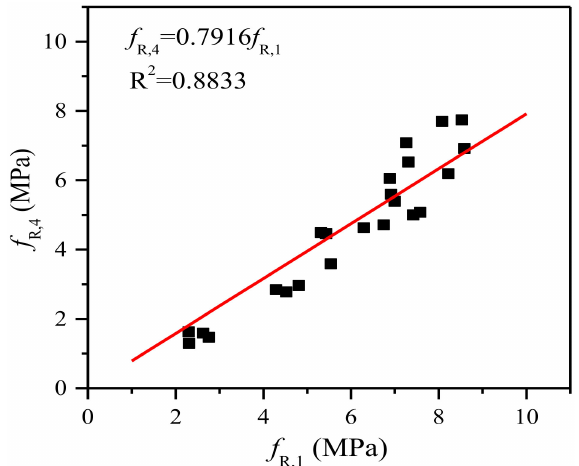
Figure 10. Relationship between f R ,1 and f R ,4